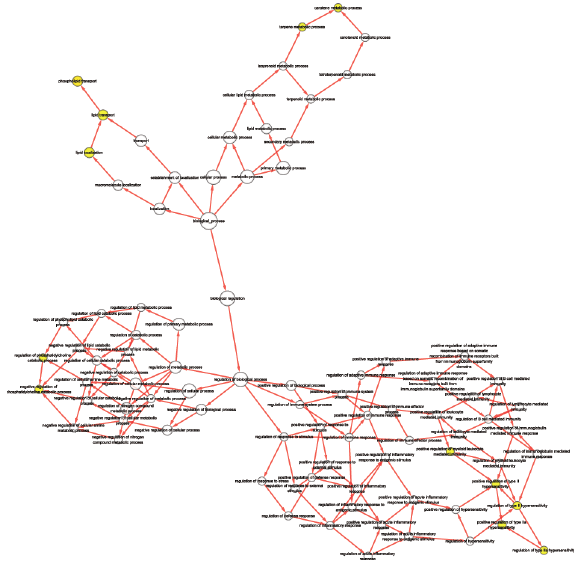
Figure 5: Enrichment network of the real hub genes using the BiNGO plug-in module of Cytoscape; nodes with yellow color indicate significant P values for the corresponding GO items; the size of the nodes indicates the number of genes enriched in the corresponding GO items; the bigger the size of the nodes, the more the genes were enriched in the corresponding GO